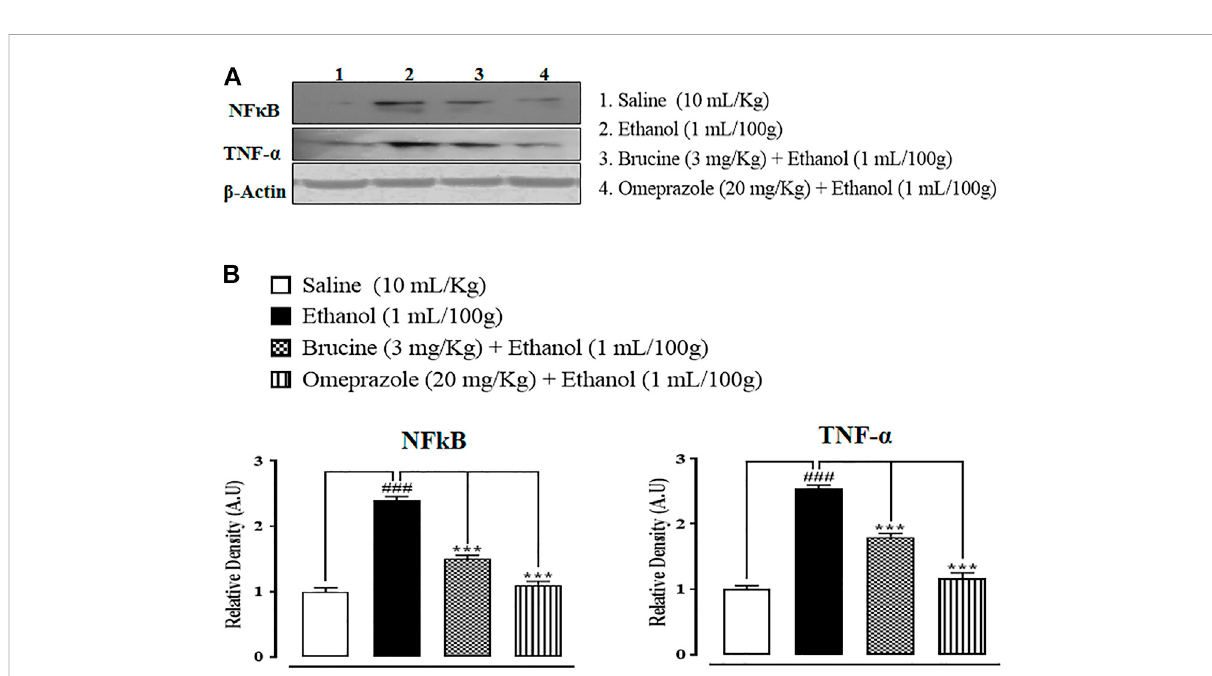
FIGURE 9 Bands (A) and graphical (B) representation of effects of brucine and omeprazole against phosphorylated nuclear factor kappa B (p-NF κ B) and tumornecrosisfactor(TNF- α )expressionsinethanol-inducedulcerratgastrictissues,usingtheWesternblottechnique.Valuesexpressedasmean± SEM ( n = 5). One-way ANOVA with post hoc Tukey ’ s test. ### p < 0.001 vs. saline group. *** p < 0.001 vs. ethanol